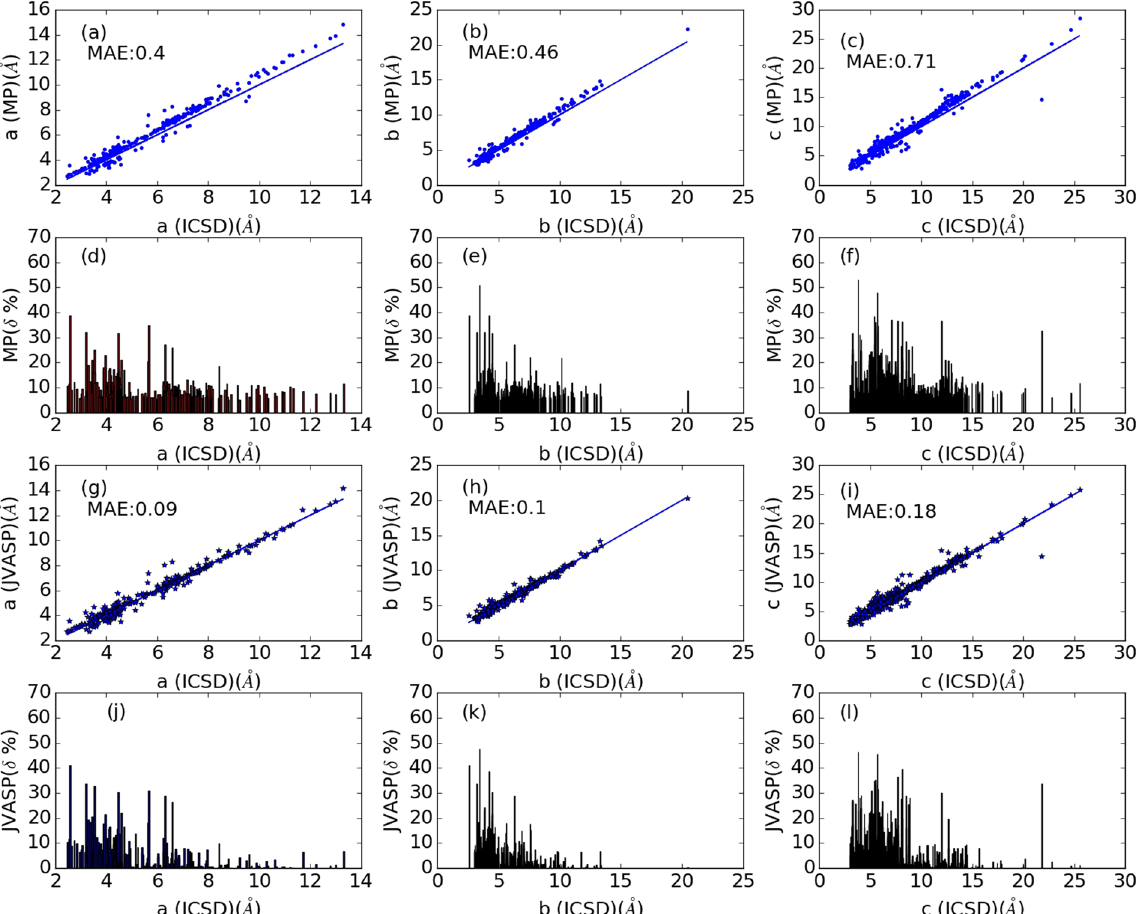
Figure 2. Comparison of lattice constants from Materials-project PBE calculations ( a – f ) and our optB88 functional calculations ( g – l ) with experimental ICSD data. Lattice constant a is examined in ( a ) PBE data and ( g ) optB88 data, while lattice constants b and c are given for PBE data in ( b ) and ( c ), respectively, and in ( h ) and ( i ) for optB88 data, respectively. In all cases the corresponding mean absolute error (using Eq. 2) is also reported, quantifying the improvement in lattice constants using optB88 over PBE. The data is plotted using dots, while the solid line is given just to indicate what the results should be for a perfect agreement between experimental and computational data. Similarly, relative percent errors with respect to the ICSD data are given in ( d – f ) for PBE a , b , and c lattice constants, respectively, and in ( j – l ) for optB88 equivalent